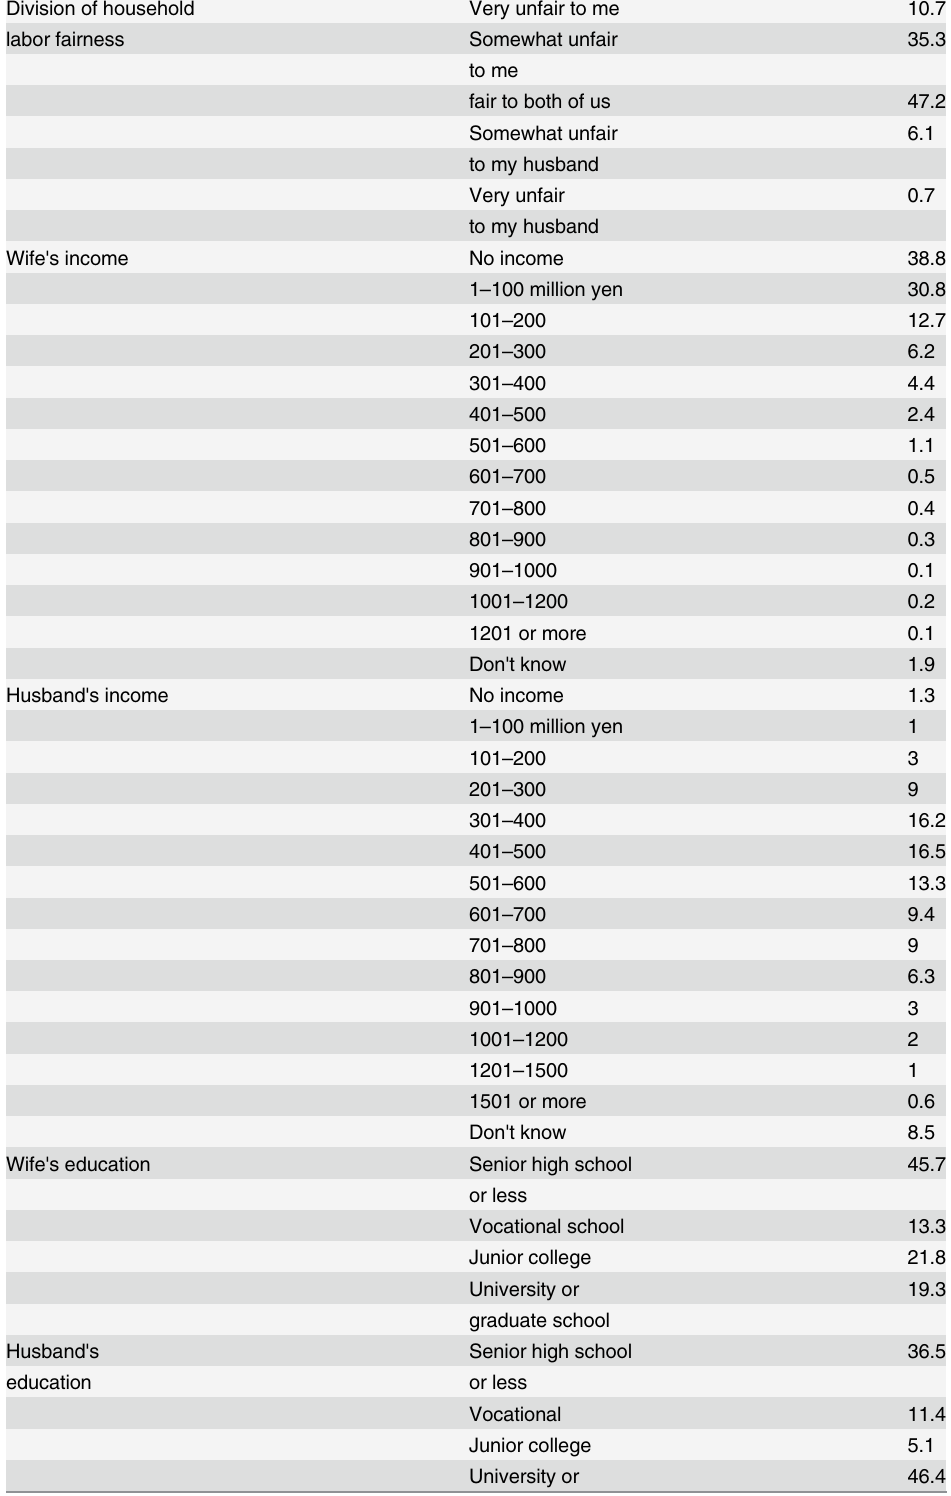
Table 3. Frequency Distribution of Categorical Variables